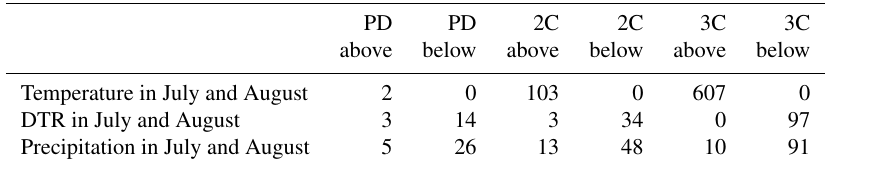
Table B1. Number of years with values above the historical maximum (“above”) and below the historical minimum (“below”) for each of the GW scenarios (PD, 2C and 3C). Each scenario has 2000 years in total. PD PD 2C 2C 3C 3C above below above below above below Temperature in July and August